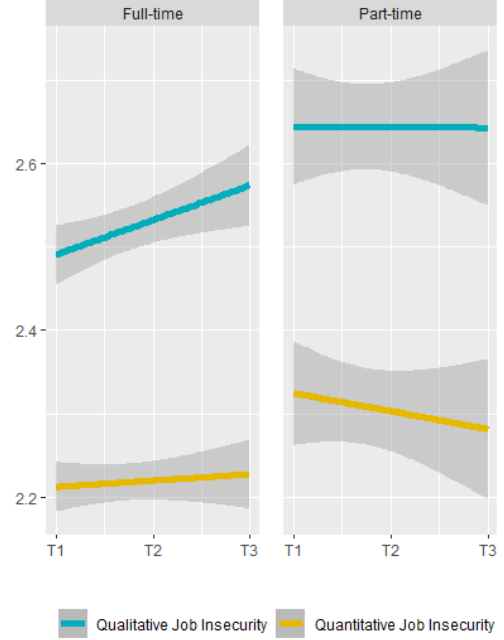
Figure A7. Part-time vs. Full-time.